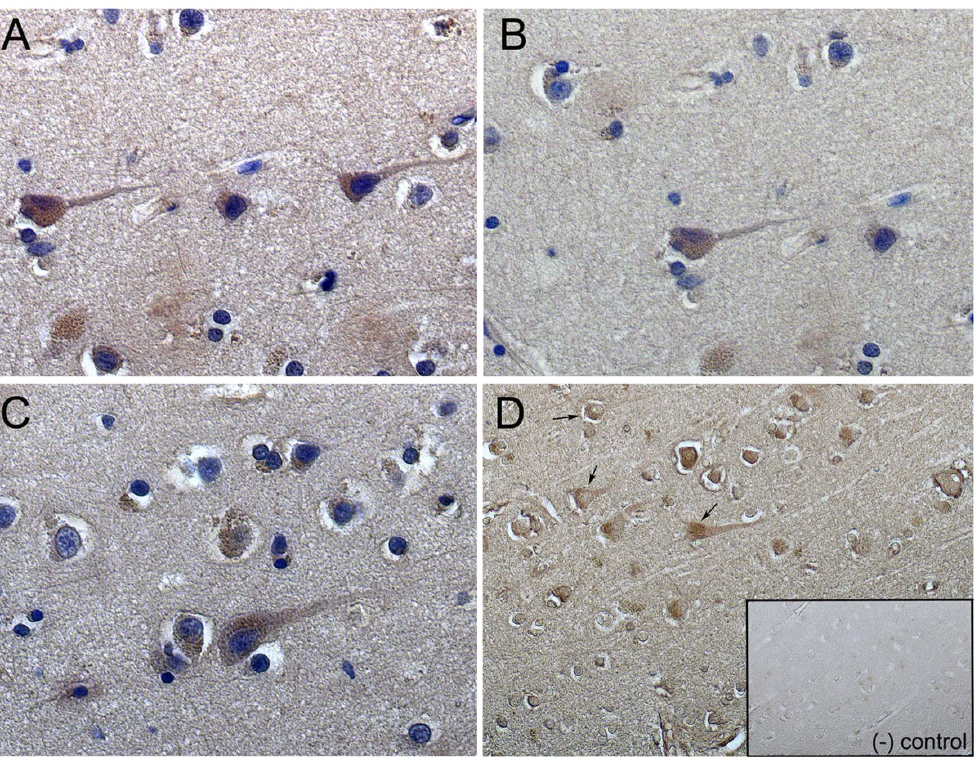
Figure 5. TIGAR is abundant in large pyramidal neurons in deep cortical layers (V–VI) of STG from the human brain. (A–C) Immunostaining for TIGAR visualized by peroxidase substrate DAB (brown staining) and counterstained with hematoxylin to visualize nuclei (blue). (D) Single staining with TIGAR; insert -negative control (secondary antibody staining). Strong staining of TIGAR was prevalent in cytoplasm and sometimes shows nuclear or perinuclear localization in large neurons as indicated by arrows